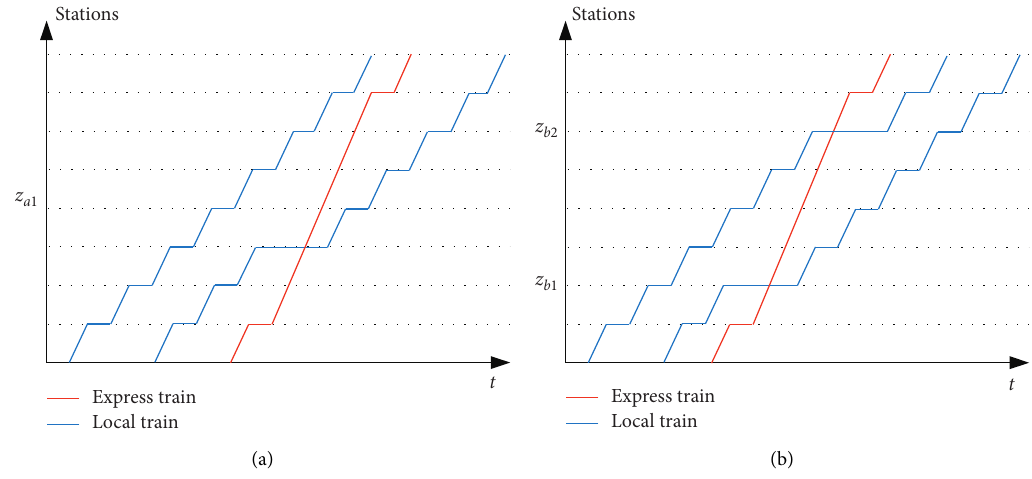
Figure 2: Illustration for overtaking behaviours in different situations.